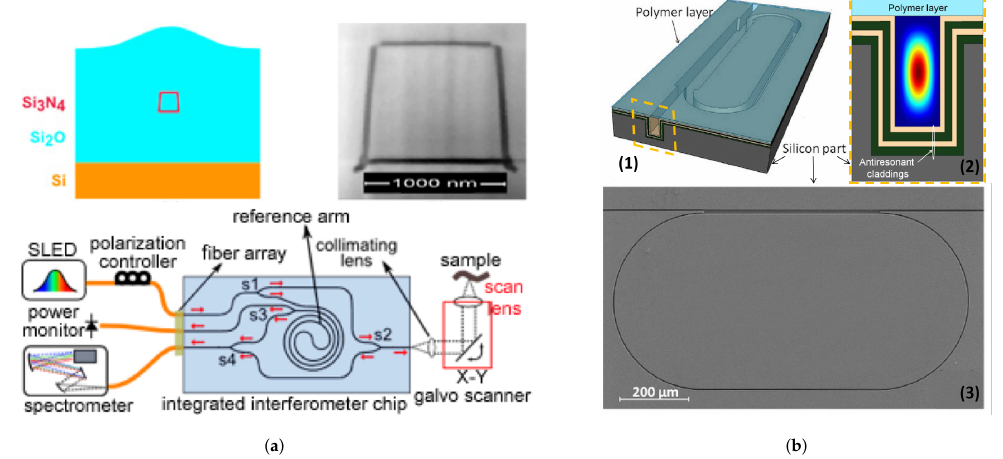
Figure 27. ( a ) Interferometric MZI using an Si 3 N 4 and SiO 2 waveguide technology called TriPleX TM . Reprinted with permission from [157] © The Optical Society. ( b ) ARROW based Ring resonator sensor: ( 1 ) a 3D schematic view of the liquid-core ring resonator, ( 2 ) a cross section of the hybrid ARROW, showing a simulated power distribution of the fundamental mode, and ( 3 ) an SEM photo of the silicon bottom layer supporting the antiresonant cladding. Adapted from [158], with the permission of